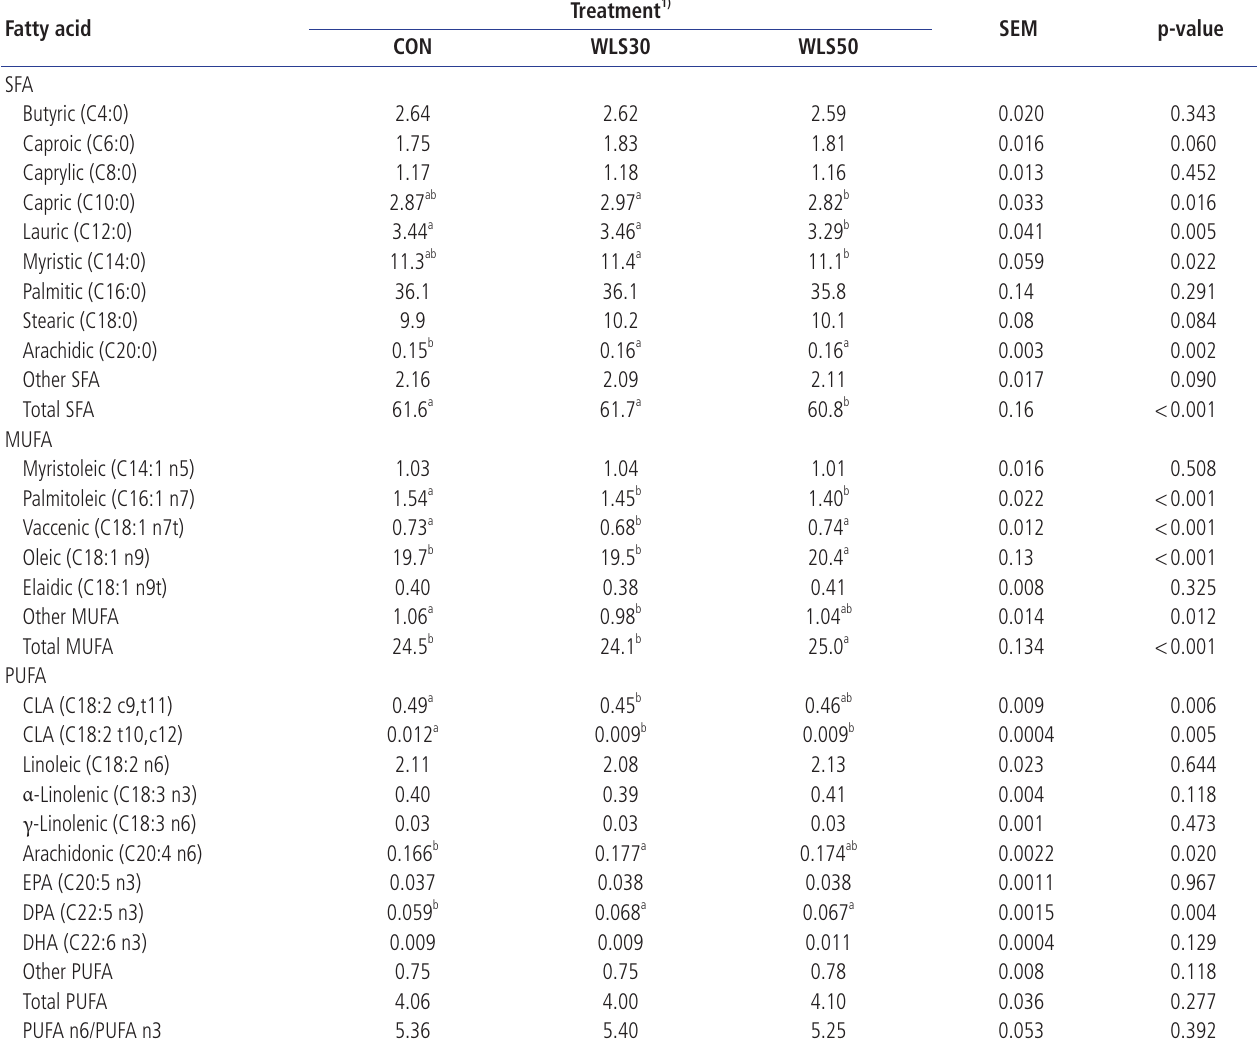
Table 4. Fatty acid profile (g/100 g total fatty acids) in the milk of cows fed the control diet or diets containing white lupine seeds Fatty